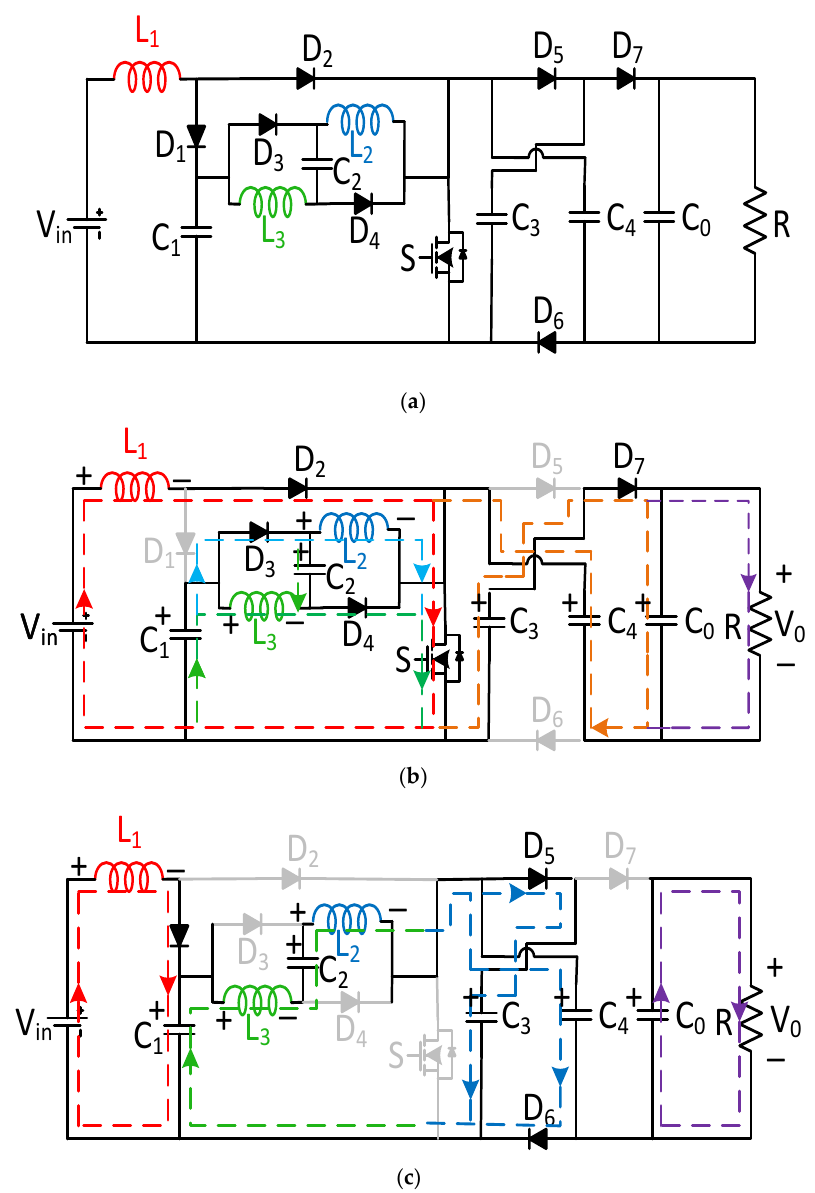
Figure 7. ( a ) Proposed converter III and operating modes: ( b ) switch is ON and ( c ) switch is OFF.